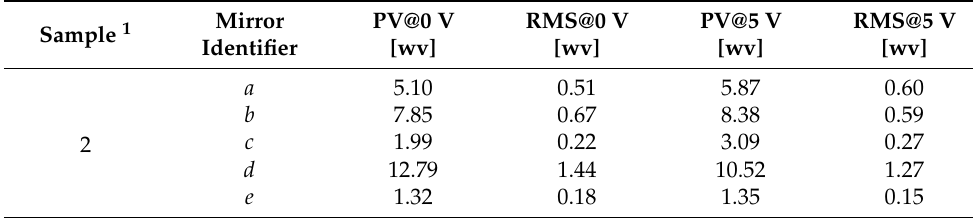
Table 2. Measured Sample 2 mirror sample optical features.